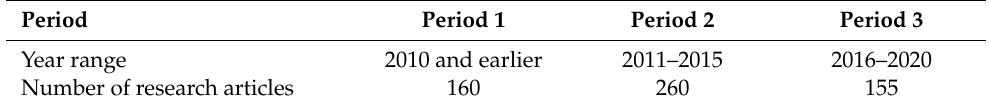
Table 3. Classification of the filtered research articles for the three time